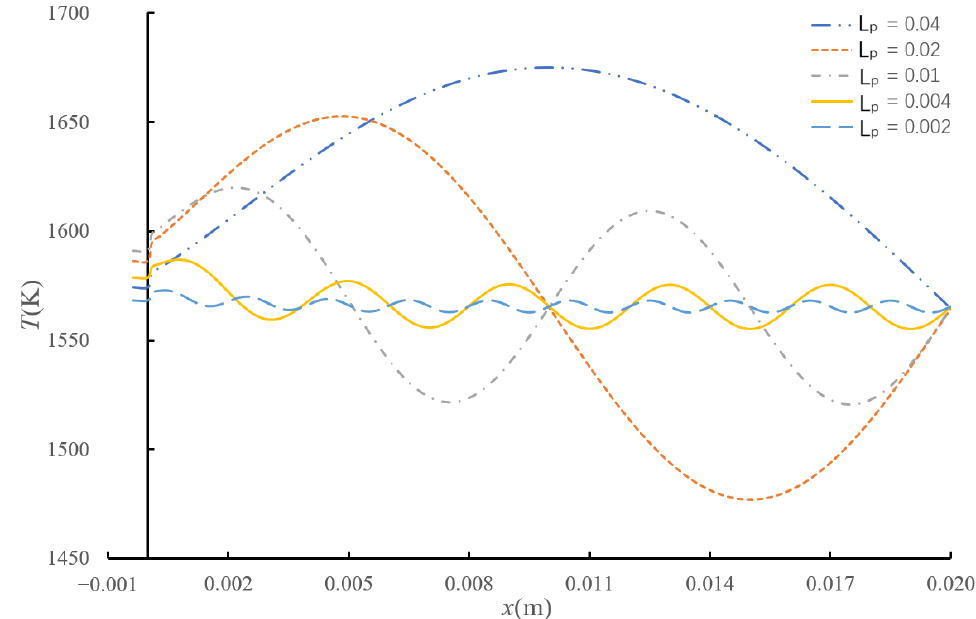
Figure 9. Pt wire temperature profiles with different gas temperature wavelengths. When φ is 0, 0.25 π , 0.50 π , 1.25 π and 1.50 π , the stable bead temperatures is 1578.8 K, 1611.3 K, 1610.9 K, 1496.5 K and 1497.8 K, respectively. The effective lengths are 12.4 mm, 12.2 mm, 12.2 mm, 12.4 mm and 12.4 mm, respectively. The influence of φ on the stable bead temperature is relatively strong, since it significantly changes the gas temperature next to the bead, and the bead temperature varies within 114.8 K for the tested cases. Its influence on the effective length is negligible and only varies within 0.2 mm for the tested cases. Figure 10 shows the Pt wire temperature profiles. After the first two periods, the wire temperature almost reaches the perfect sinusoidal profile.